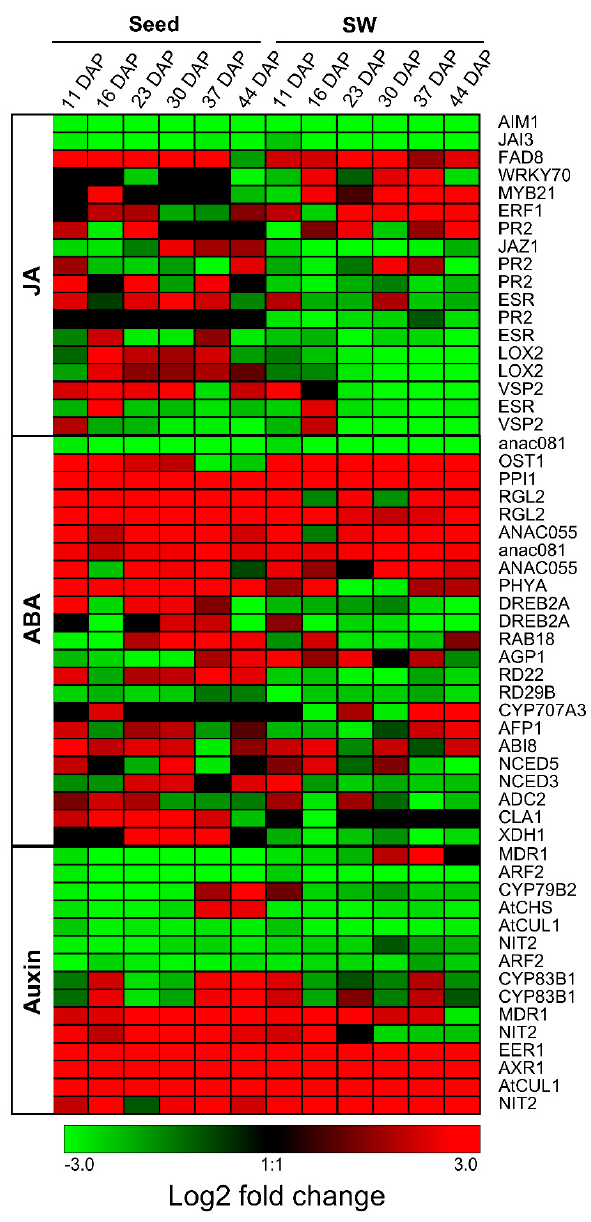
Figure 11. Heat map of differentially expressed jasmonate (JA), abscisic acid (ABA), and auxin genes. Red and green represent upregulated genes in the HOCL and LOCL, respectively.